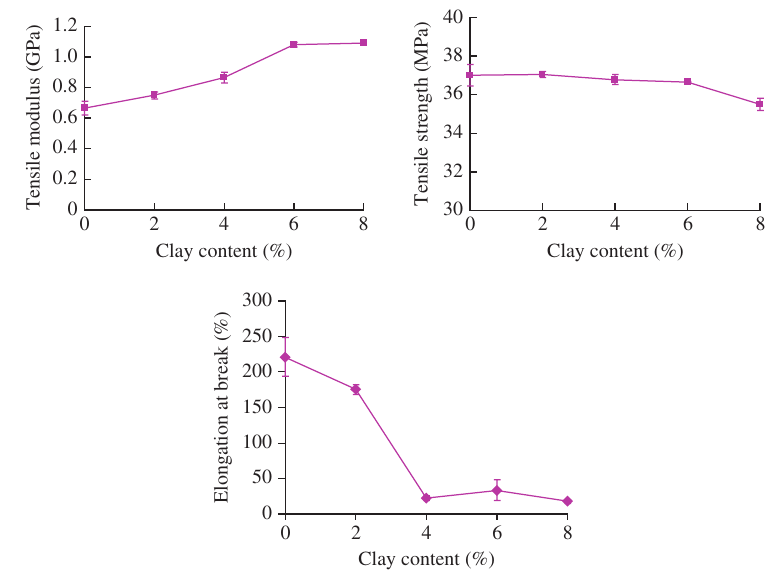
Figure 3 Tensile properties of PBS/organoclay